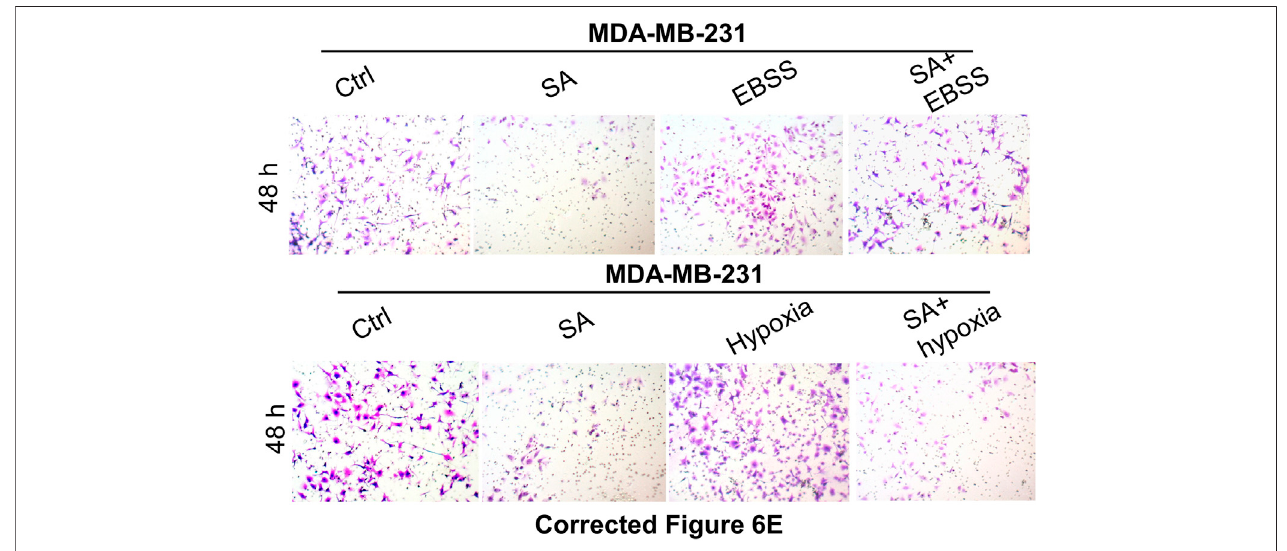
FIGURE6| SAsuppressesautophagy-mediatedmetastaticprocessesduringstarvationorhypoxia. (E) woundhealingassaysaswellastranswellinvasionassays re fl ected the in fl uences of SA on cell growth or invasiveness under starvation (EBSS) or hypoxia (cobalt chloride).